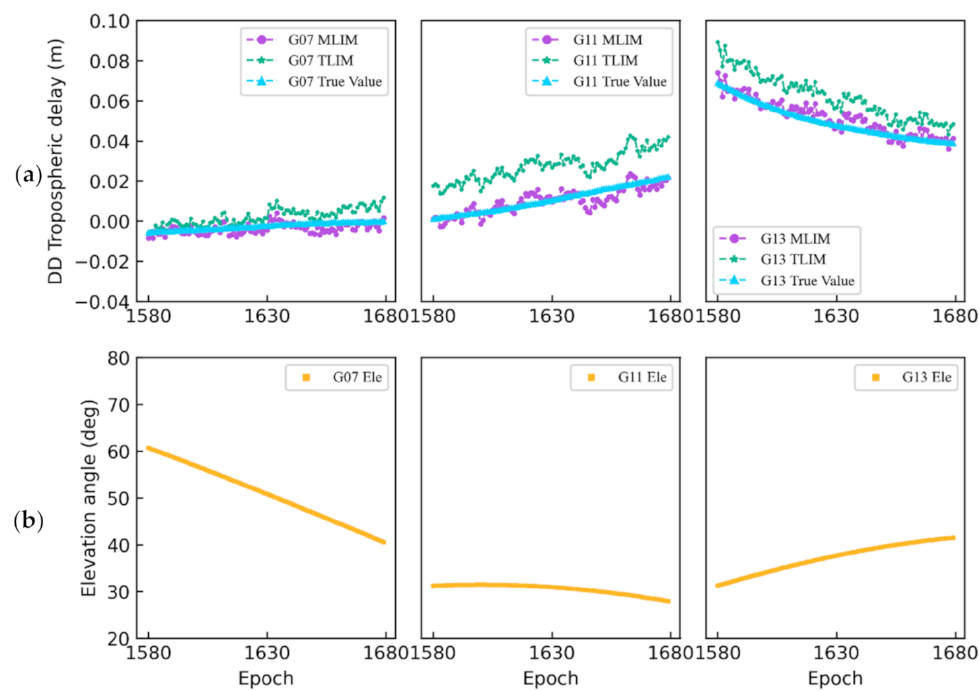
Figure 10. The DD tropospheric delay obtained by different methods ( a ) and elevation angles ( b ) for satellites G07, G11, and G13 at the rover station